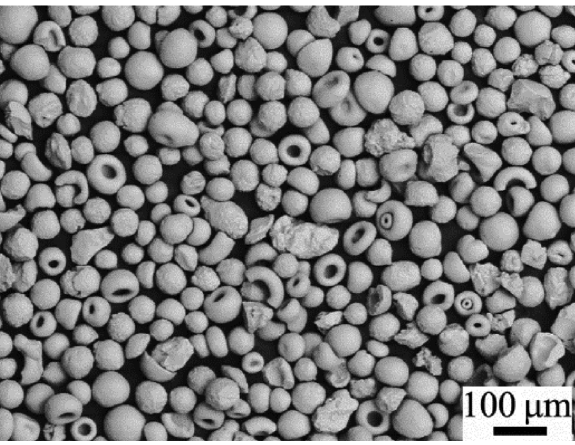
Figure 3: Spray Watch 2i